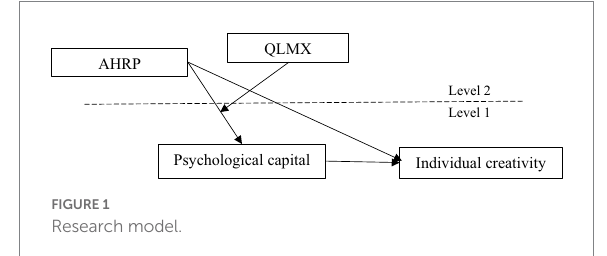
FIGURE 1 Research